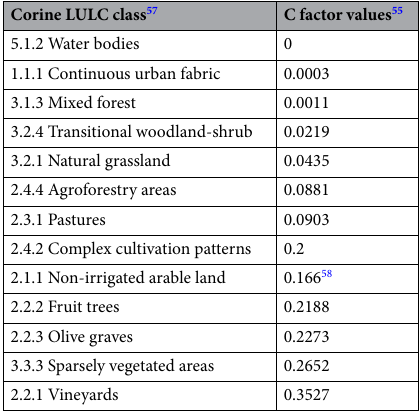
Table 1. C factor values adopted in this research.